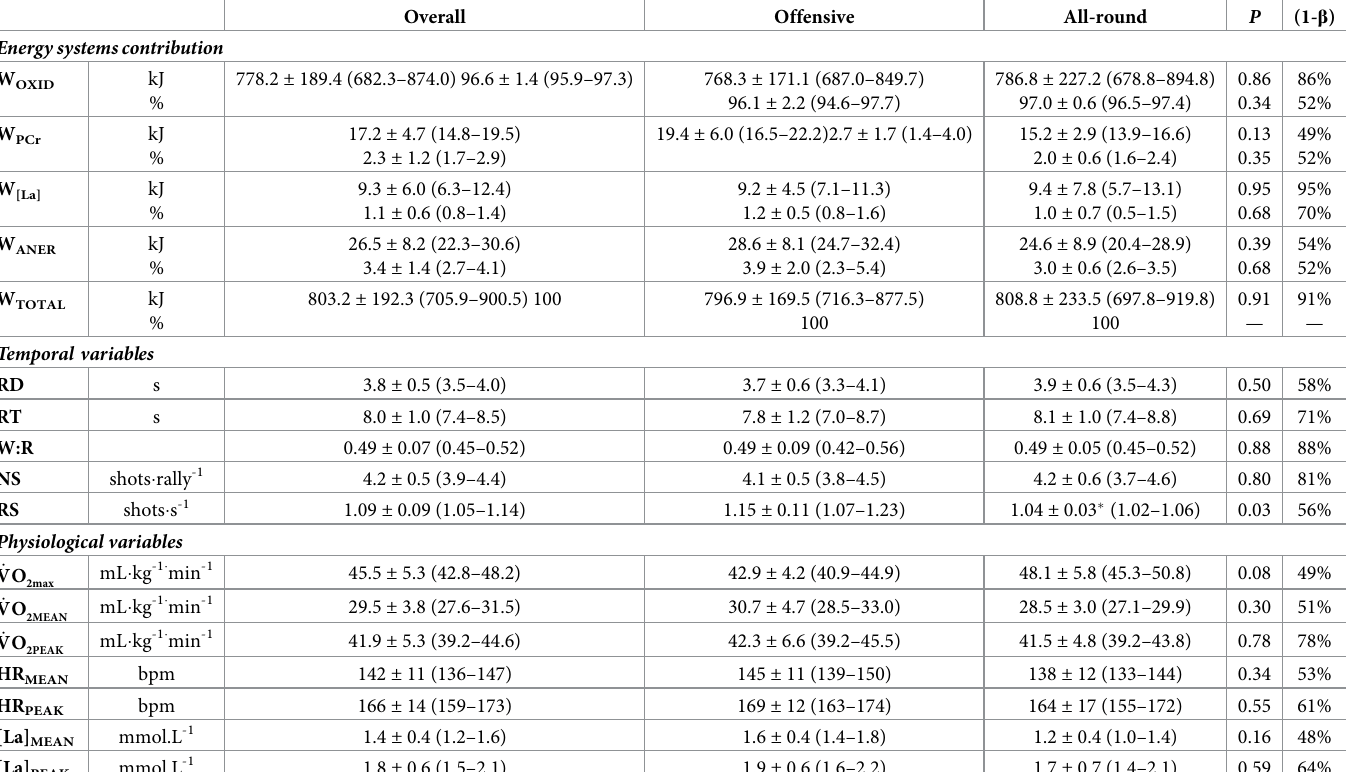
Table 1. Comparisons between offensive and all-round playing style. Mean ± SD